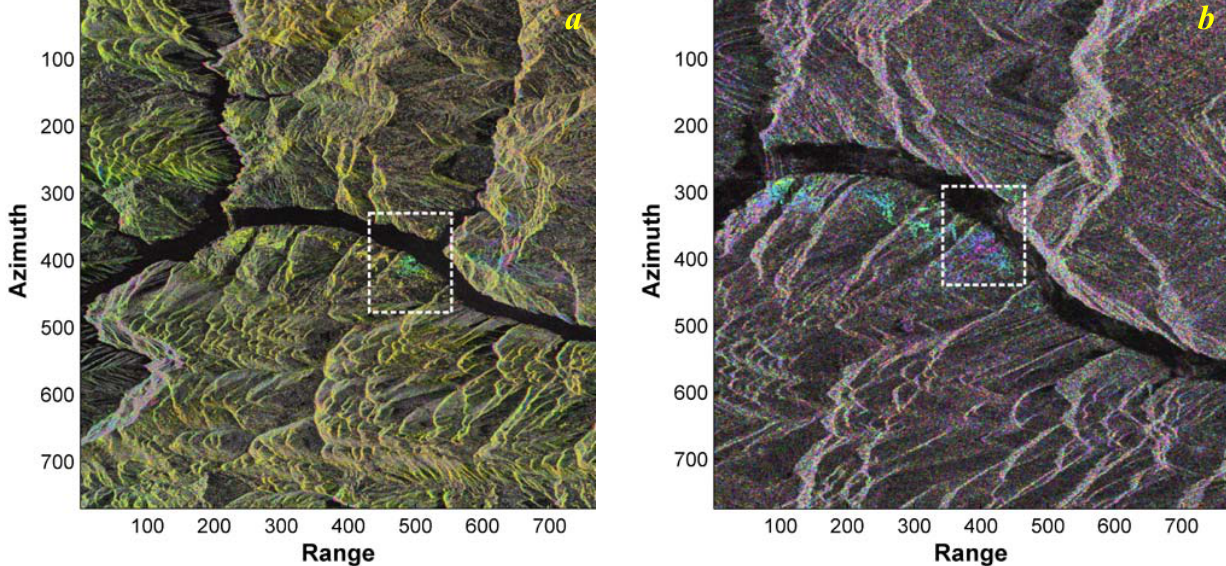
Figure 3. Differential interferograms after removal of topographic phase. ( a ) Interferogram of Advanced Land Observing Satellite (ALOS) Phased Array L-band Synthetic Aperture Radar (PALSAR) data pair (2007/12/30 vs. 2010/02/19, B ascending Environmental Satellite (ENVISAT) Advanced Synthetic Aperture Radar (ASAR) data pair (2009/05/16 vs. 2009/11/07, B descending ENVISAT ASAR data pair (2009/05/17 vs. 2009/07/26, B square indicates the location of Huangtupo